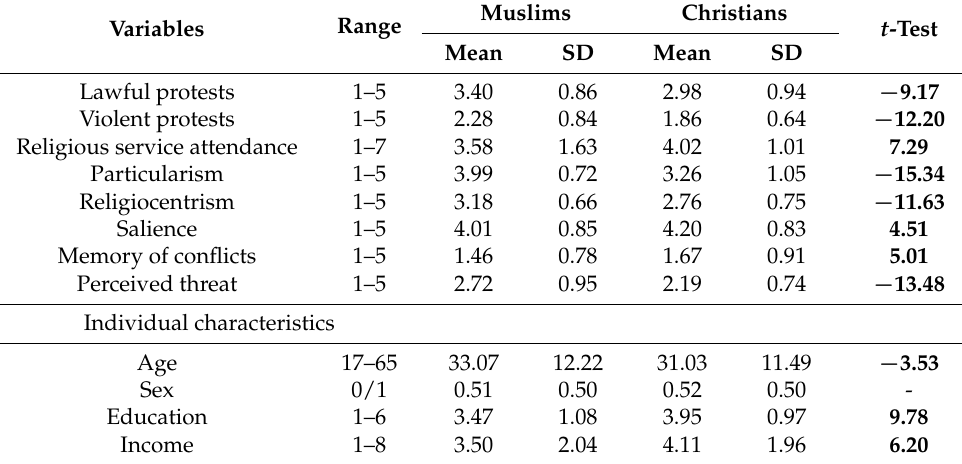
Table 1. Descriptive statistics and mean differences.